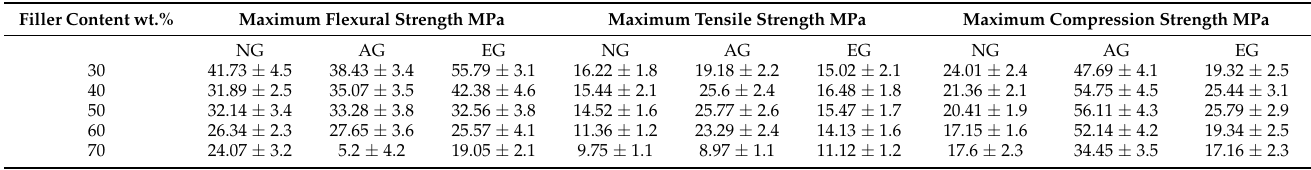
Table 3. Mechanical properties of PSU-based composites filled with NG, AG and EG. Filler Content wt.%